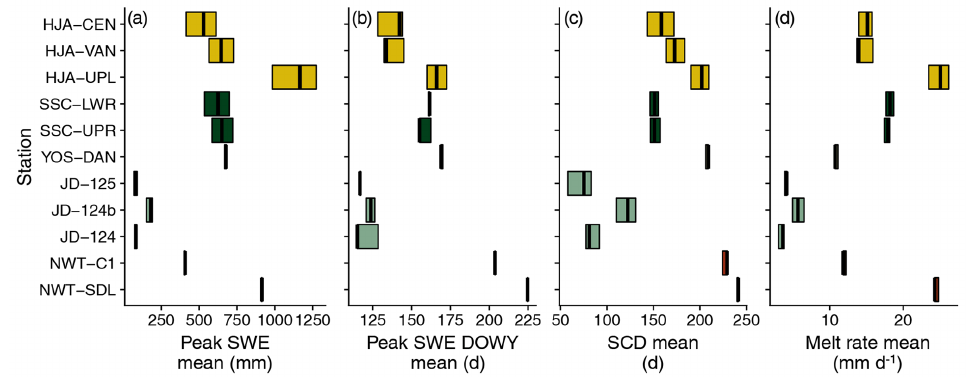
Figure 9. Mean peak SWE (a) , peak SWE day of water year (DOWY; b ), snow cover duration (SCD; c ), and melt rate (d) for the different stations. The width of the bar in each plot represents the spread between the mean snow cover metric value when the model was run with the optimized threshold plus 1 ◦ C and the optimized threshold minus 1 ◦ C. The center line represents the snow cover metric value when the model was run with the optimized threshold. Note: at NWT, only − 1 ◦ C from the optimized value of 3 ◦ C was evaluated because we did not include a 4 ◦ C threshold in this work.